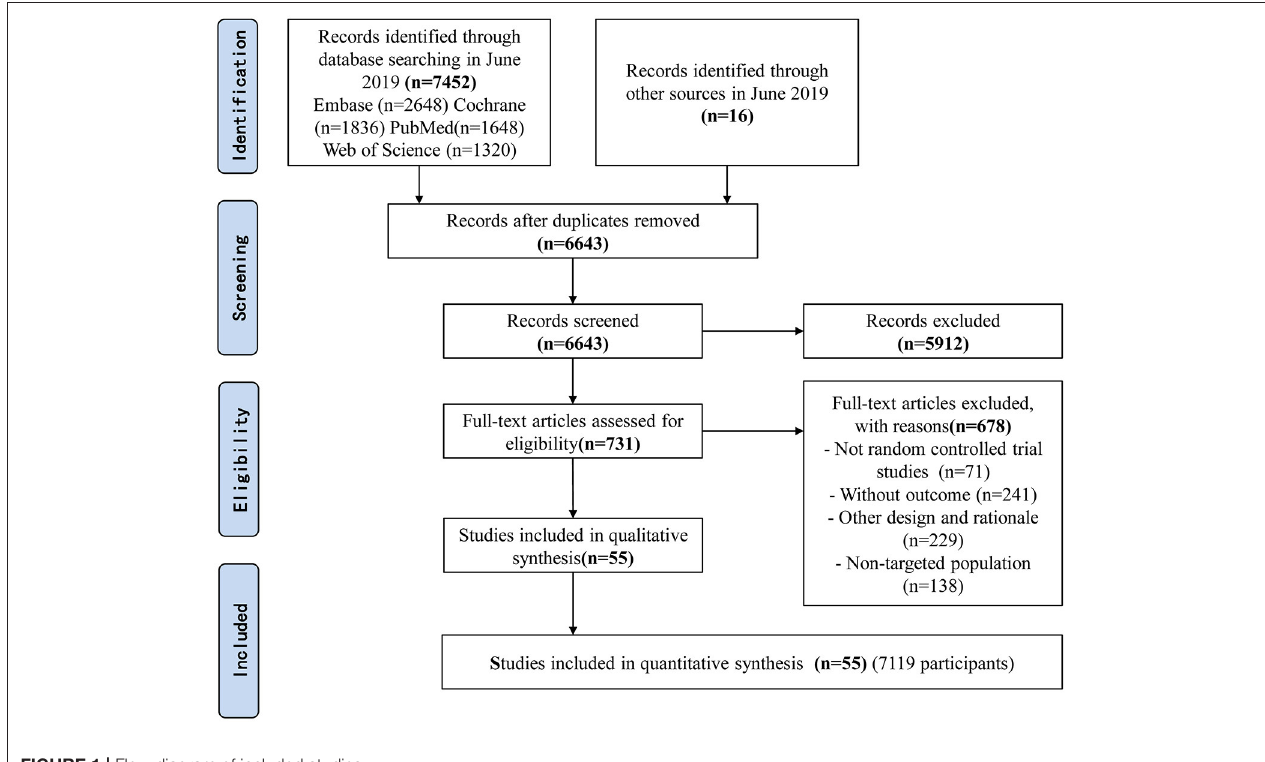
FIGURE 1 | Flow diagram of included studies.